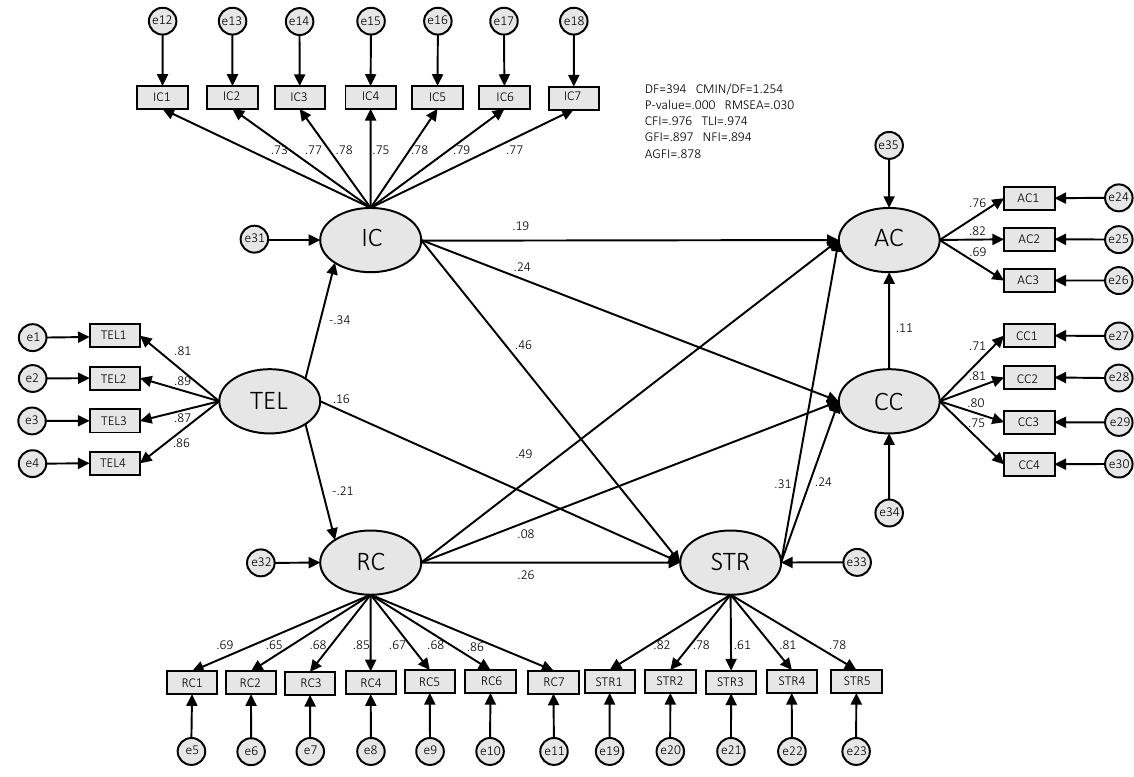
Figure 3. Structural model of the